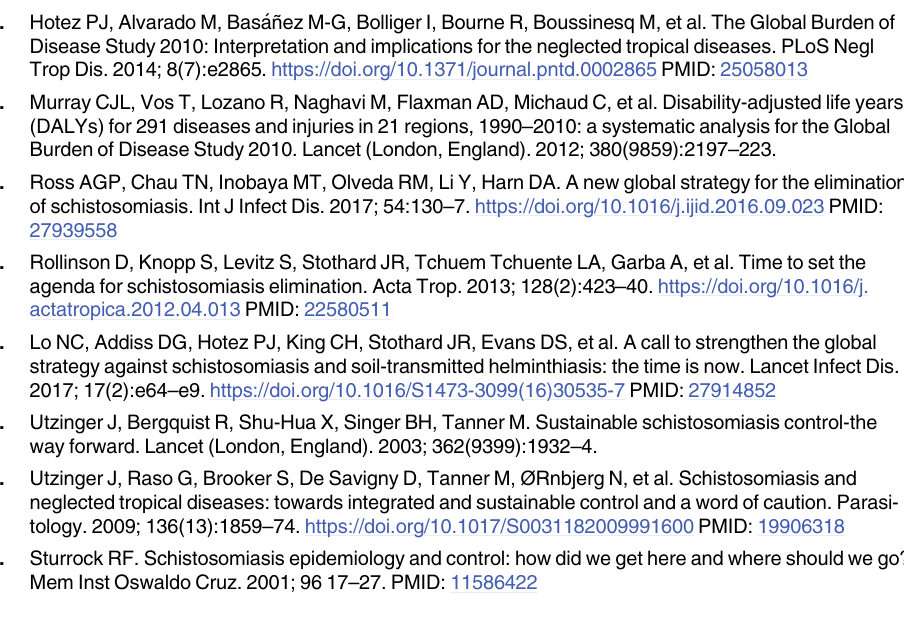
S1 Supporting Information. Search protocol. Search terms and examples of search strategy for two databases. S1 Table. Classified included and excluded studies. Classification codes, and a list of included and excluded